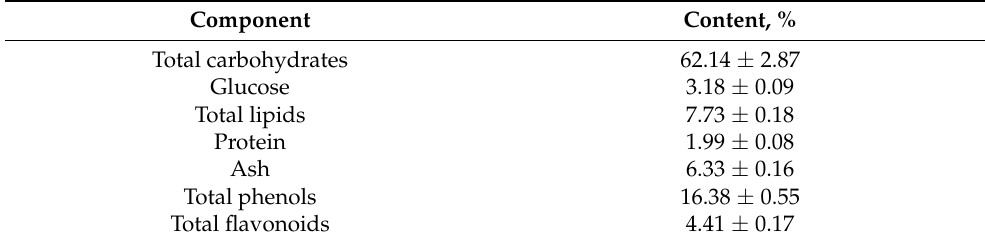
Table 1. Chemical composition of sunflower meal ethanol-wash